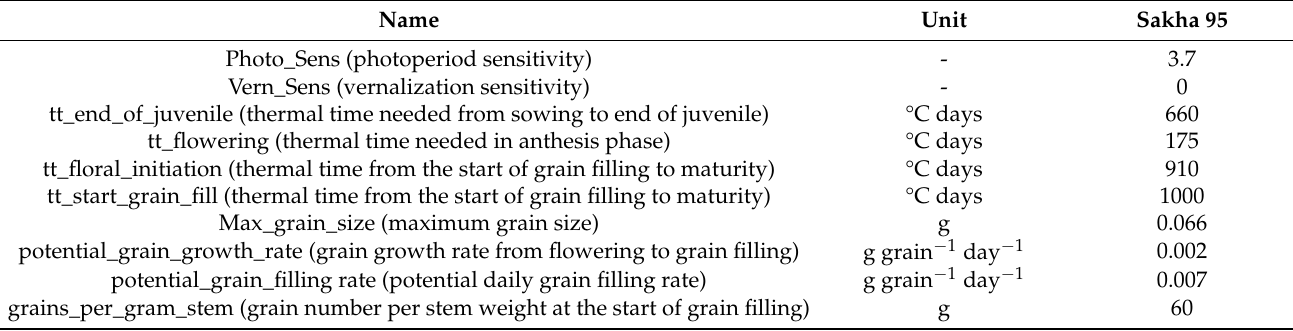
Table 3. Cultivar parameters of cv. Sakha 95 calibrated for the APSIM-Wheat model. Name Sakha